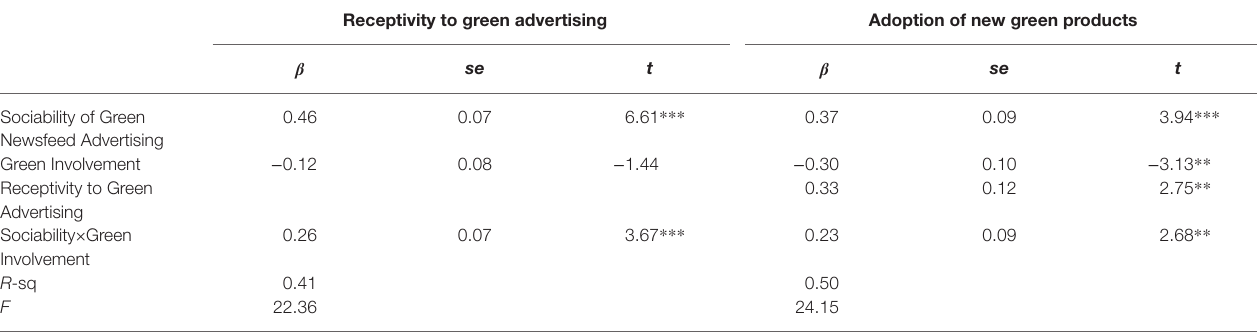
TABLE 4 | Moderated mediation model test. Receptivity to green advertising Adoption of new green products